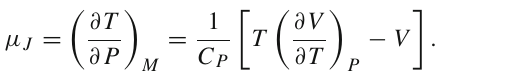
Fig. 5 The isenthalpy process in P-T graph with fixed M = 15 , 18 , 20 , 22 from bottom to top(black lines). We set q = 10 and α = 1. The red points in each process denote the transition points of the cooling and heating regions for the related M , satisfying μ J = 0. The blue line is P i − T i border